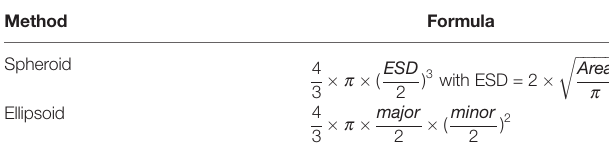
TABLE 1 | Methods of calculating individual biovolume with area (mm2); ESD, the equivalent spherical diameter equivalent (mm); major, the major axis (mm) of the best fi t ellipse; minor, the minor axis (mm) of the most suitable